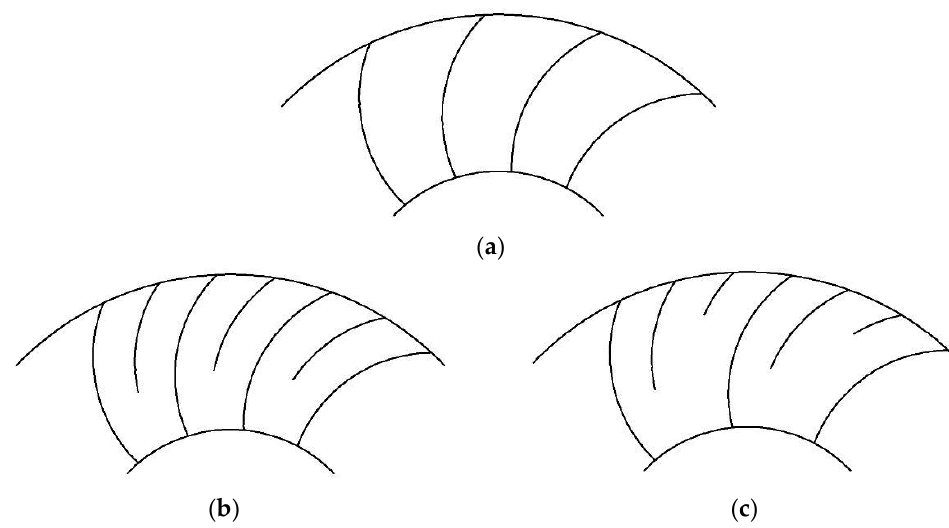
Figure 2. Different types of impellers: ( a ) Impeller without splitter blades; ( b ) Impeller with one row of splitter blades; ( c ) Impeller with two rows of splitter blades. If the impeller has one row of splitter blades, Z i 2 = 2Z i 1 , the leading edge section of the splitter blade marked by ⓐ is a part of O 2 F, as seen in Figure 2. The angle of the splitter- blade leading edge <!--